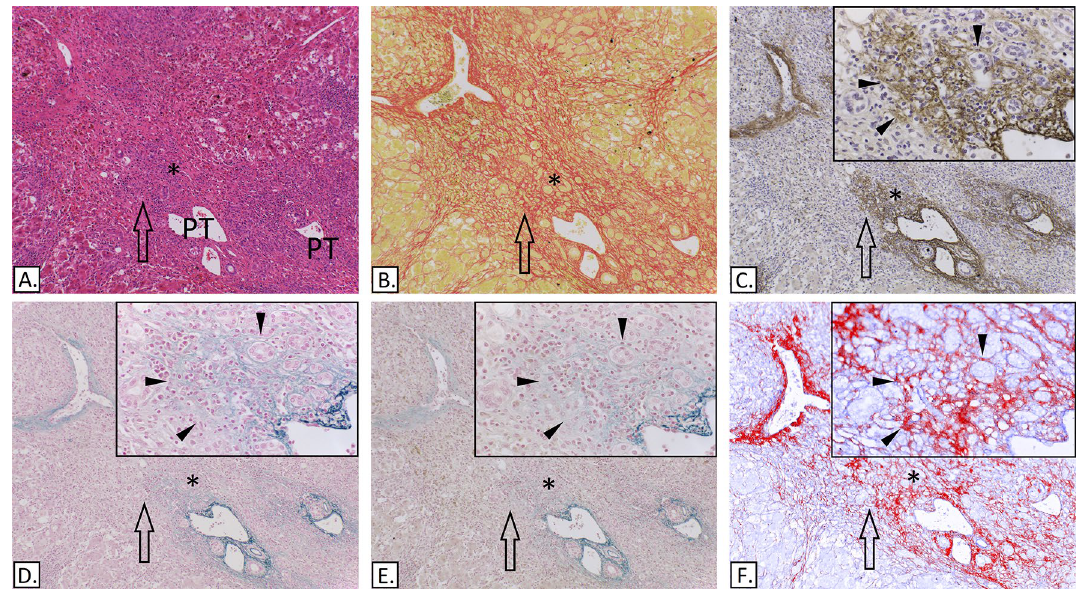
Figure 6. Submassive hepatic necrosis. ( A ) H&E. ( B ) Picro-Sirius red. ( C ) IHC-Elastin (ab9519). ( D ) Victoria Blue. ( E ) Modified Victoria blue—no oxidation step. ( F ) IHC-collagen I (ab6308) in red & collagen III (ab7778) in blue, spectrally unmixed channels from Nuance camera + software. The portal tracts (PT) are labelled, the asterisks show an area of ductular reaction and the arrows indicate the same periportal area for comparison of different stains. The insets are high-power images of the peri-portal ductular reaction the triangles are indicating the elastic fibres (C, D, E) and the collagen I (F). In this case the ductules are surrounded by collagen I (F) and there is delicate elastic fibre deposition (C & D), note the differential staining between the Victoria blue (D) and the modified method